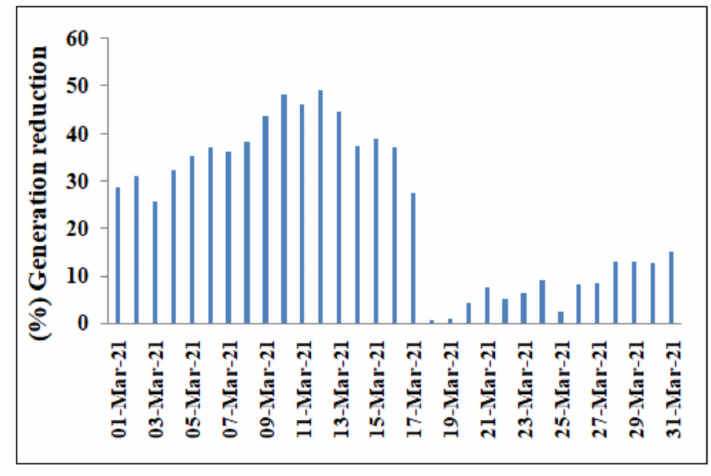
Figure 6. Calculated % Generation loss for one month at PV plant (RBI, Kolkata).